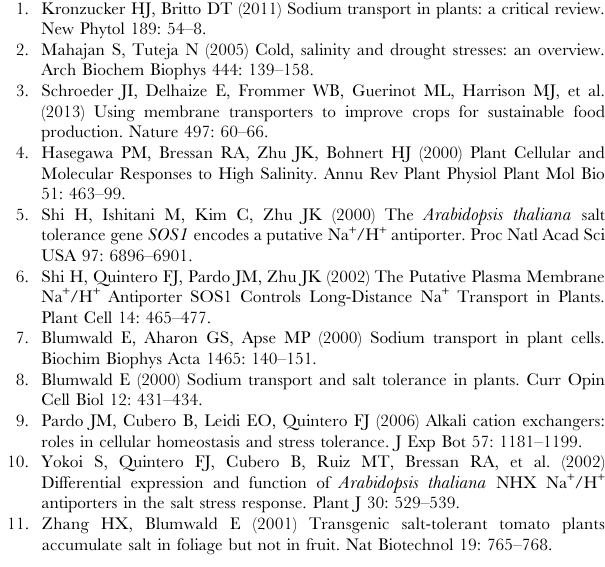
Figure S1 Multiple sequence alignment was performed for amino acid sequences of plant NHX proteins using CLUSTAL W.